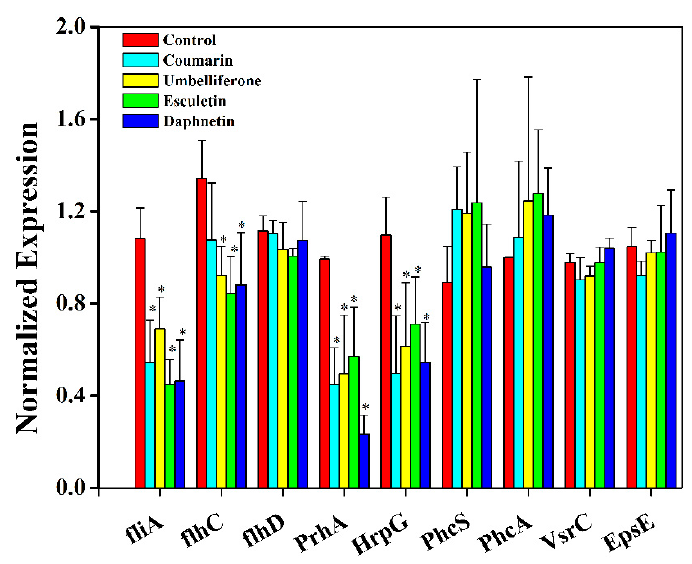
Figure 5. Expression of some virulence-associated genes of R. solanacearum were quantified by qRT-PCR treated with or without coumarins. R. solanacearum was cultured in B medium treated with DMSO or the coumarins using the IC 50 concentration (coumarin 58.09 mg/L, umbelliferone 37.15 mg/L, esculetin 24.15 mg/L and daphnetin 8.73 mg/L). Ser C was used as the reference gene to normalize the gene expression using the ∆∆ Cq method. The results reflect three biological replicates and error bars indicate the standard deviation. (* indicated p < 0.05)